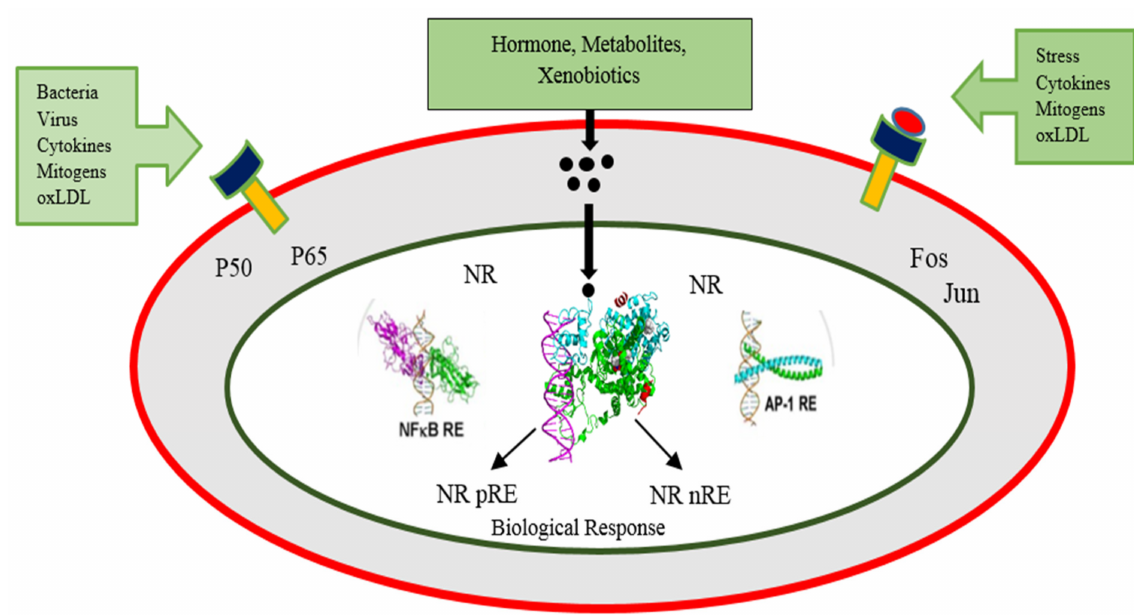
Figure 2. Nuclear receptors work in two apparent manners. Firstly, through the binding of a ligand, these receptors can frame, Heterodimers with RXR that outcomes in their connection with a specific positive response element of gene and, in this manner, can cause transcription of mRNA of genes that are targeted. On the other hand, repressive, negative response elements (nRE) have likewise been observed to interact with these receptors